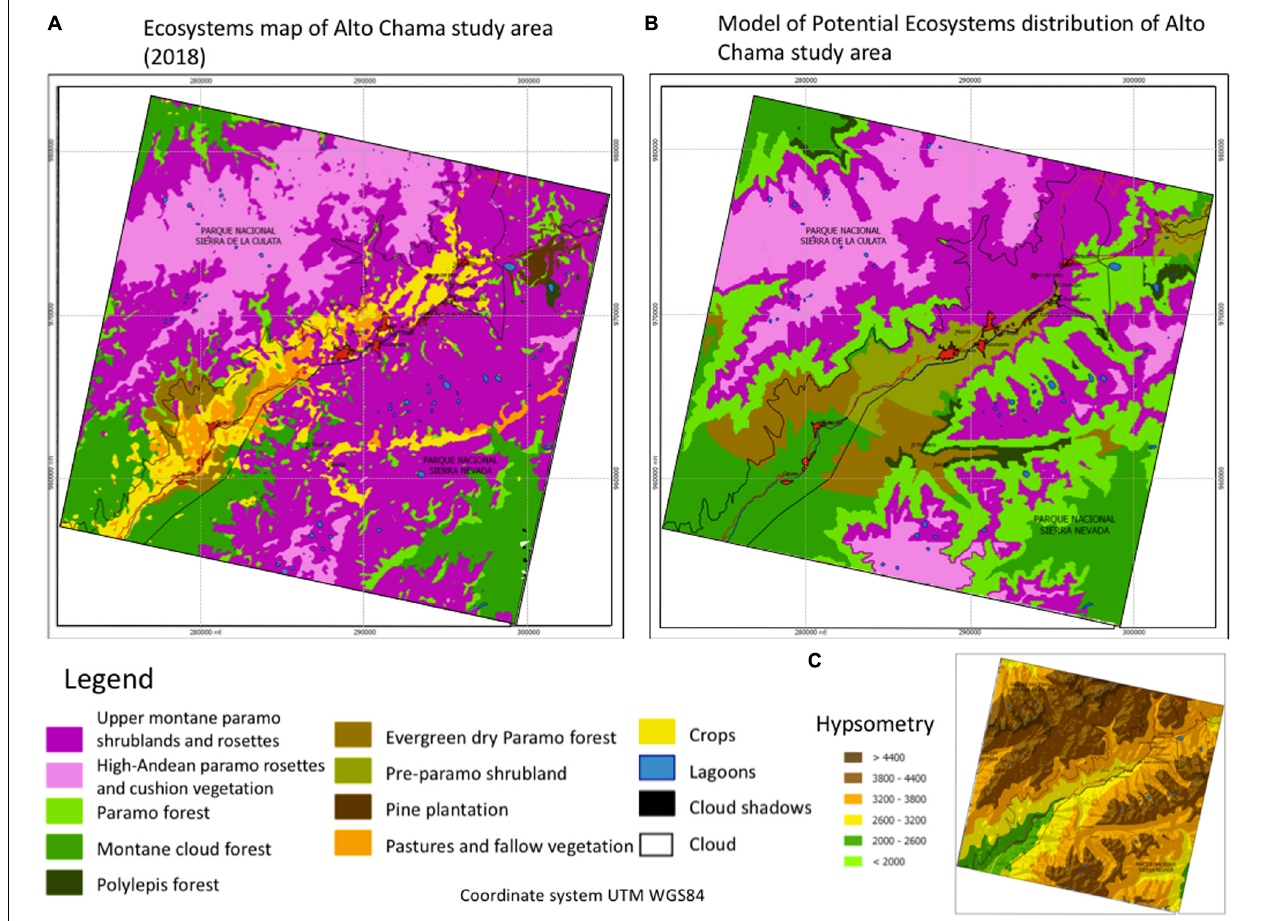
FIGURE 6 | (A) Ecosystems map, (B) Map of ecosystems potential distribution, and (C) Hypsometry map, for the Alto Chama study area, Cordillera de Mérida, Venezuela. The ecosystem types legend and of the study area are showed. Coordinates in the UTM system are indicated.